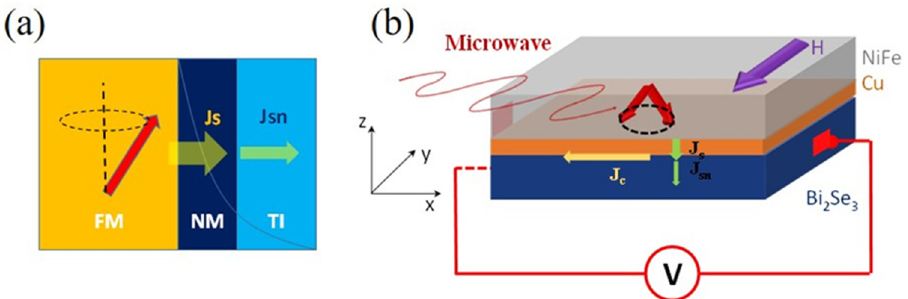
Figure 1. Schematic of spin pumping measurements of tri-layer samples, with a nonmagnetic (NM) spacer introduced in between the FM and TI layer. Upon microwave excitation, the magnetization of the FM layer processes and pumps a pure spin current into the NM layer and induces a charge current via the IEE. Due to the potential barrier at the NM interface, the pumped spin current J S is partially depleted at the interface, and only part of the spin current J SN propagates in the TI layer. ( a ) Cross-sectional view. ( b ) 3D view.